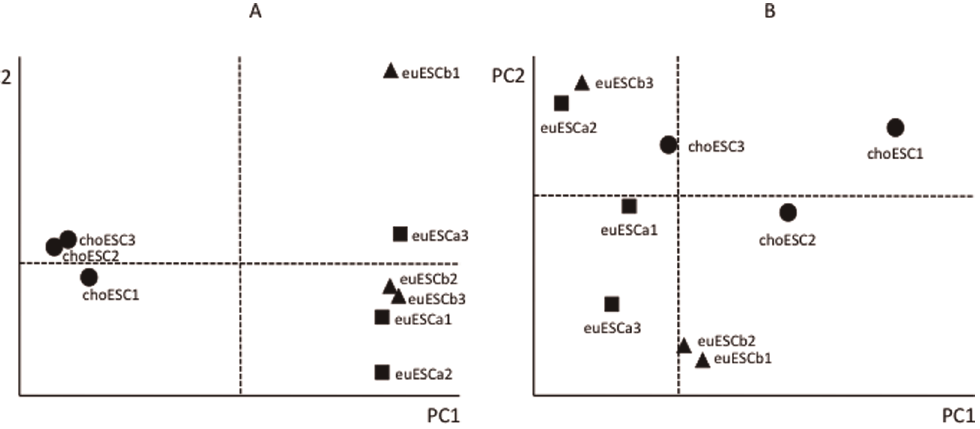
Figure 2. The results of the principal component analysis of genome-wide DNA methylation status (A) and the transcriptome analysis (B). The closed squares, closed triangles and closed circles represent euESCa, euESCb and choESC, respectively. The PC1 axis clearly distinguished the choESC from the euESC, whereas the euESCa and euESCb were identical in DNA methylation (A). No clear clusters were observed in the transcriptome analysis